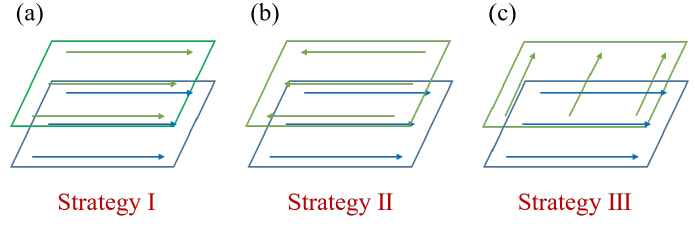
Figure 16. Schematics of layer-wise scan strategy for ( a ) Strategy I: unidirectional scanning without layer-wise rotation, ( b ) Strategy II: unidirectional scanning with layer-wise rotation of 180°, and ( c ) Strategy III: unidirectional scanning with layer-wise rotation of